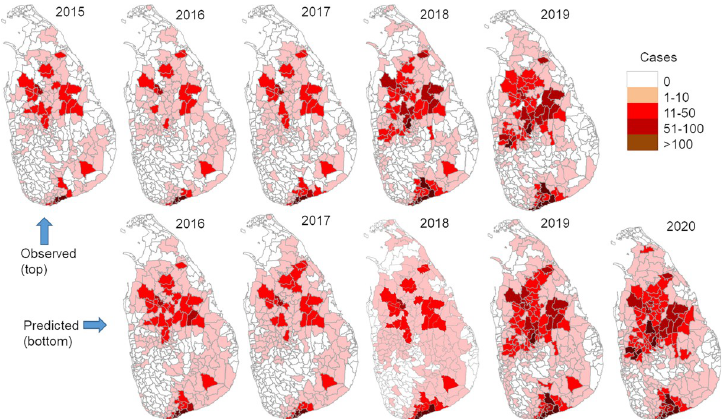
Fig 6. Observed and model-predicted leishmaniasis cases by division and year. Source: Authors’ own map using data from https://data.humdata.org/dataset/sri-lanka-administrative-levels-0-4-boundaries.